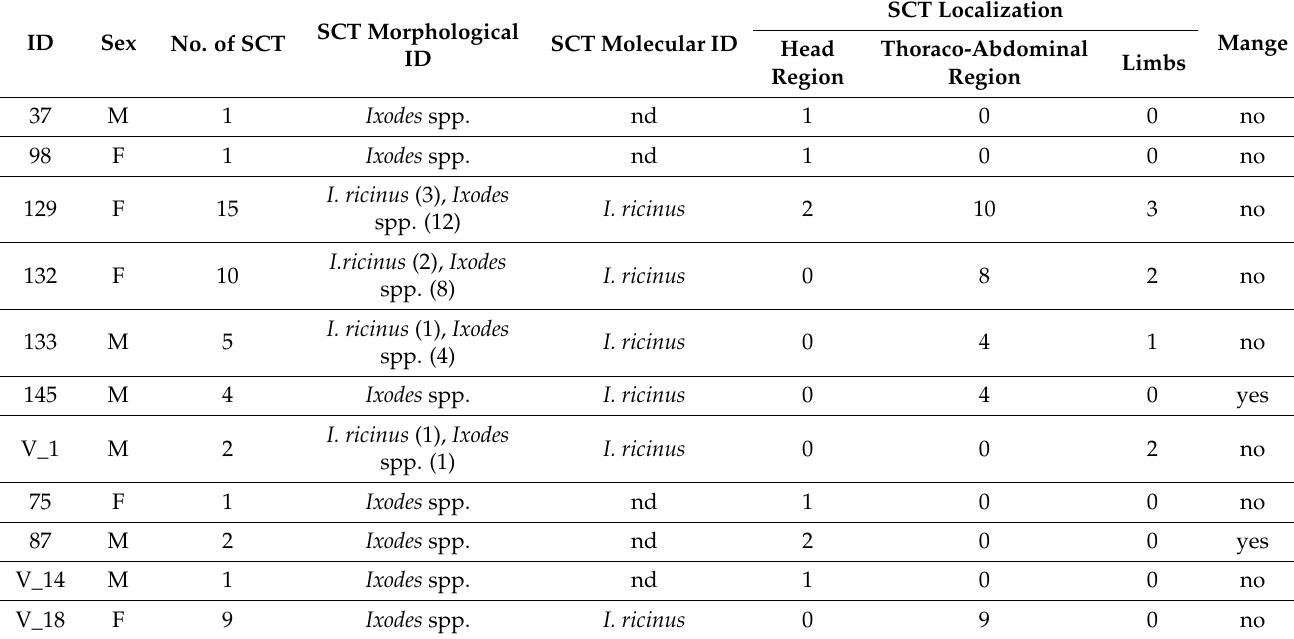
Table 2. Red foxes found positive for SCT. Body localization is intended as the coat area where ticks were found in the subcutis, namely the head region (including ears and neck), the thoraco-abdominal region (including axillar region, shoulder, back, belly, inguinal region) and limbs (including, tail, forelimbs, hindlimbs). Morphological identification has been performed under stereomicroscope following morphological criteria, while molecular ID refers to the outcome of cox1 gene and 16S rDNA amplification (see Method section).